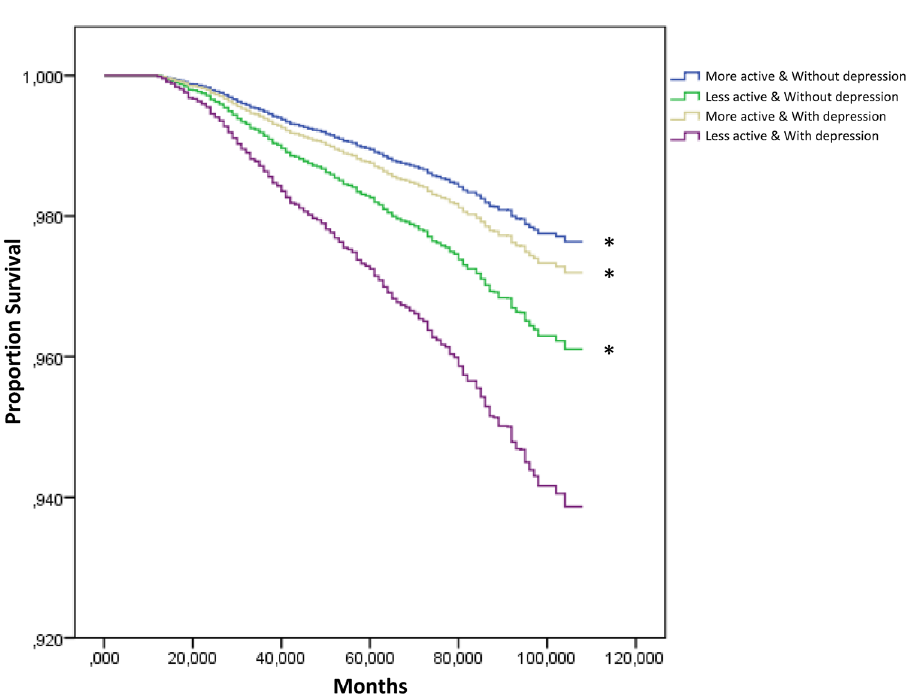
Figure 2. Survival curves for all-cause mortality according to physical activity group and depression status. Data are representative of non-institutionalized American population. Less active: Performed < 600 MET-min/ week; More active: Performed ≥ 600 MET-min/week; With depression: Scored ≥ 10 in the PHQ-9; Without depression: Scored < 10 in the PHQ-9. Curves are adjusted by age, sex, race/ethnicity, annual household